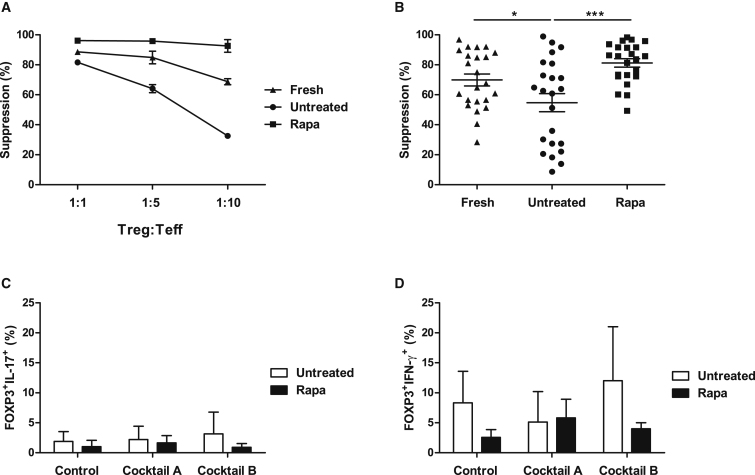
Suppressive Ability and Plasticity of Freshly Isolated and Expanded Treg Lines(A) Suppressive ability of Tregs was measured as a decrease of proliferation of effector T cells in the presence of different concentrations of Tregs (Treg:Teff 1:1, 1:5, and 1:10). Graph denotes a representative suppression assay with freshly isolated Tregs before and after the 36-day expansion in the presence and absence of rapamycin. (B) Cumulative data on the average suppressive ability of 25 Treg lines following isolation (fresh) and post expansion in the presence and absence of rapamycin at a Treg:Teff ratio of 1:1. *p < 0.05; **p < 0.01; ***p < 0.001. Analysis of the plasticity and stability of the untreated or rapa-treated Treg lines after a 1-week culture in the presence of a pro-inflammatory milieu. (C and D) Percentage of FOXP3+IL-17+ cells (C) and FOXP3+IFN-γ+ cells (D) analyzed by intracellular staining. Data represent the mean ± SD of 3 independent experiments. Statistical analysis was performed using 1-way ANOVA, and where there was a significant difference, this is indicated. Control: IL-2 (10 IU/mL) only; Cocktail A: IL-2, IL-1β, IL-6, and TGF-β; Cocktail B: IL-2, IL-21, IL-23, and TGF-β (see text for details).